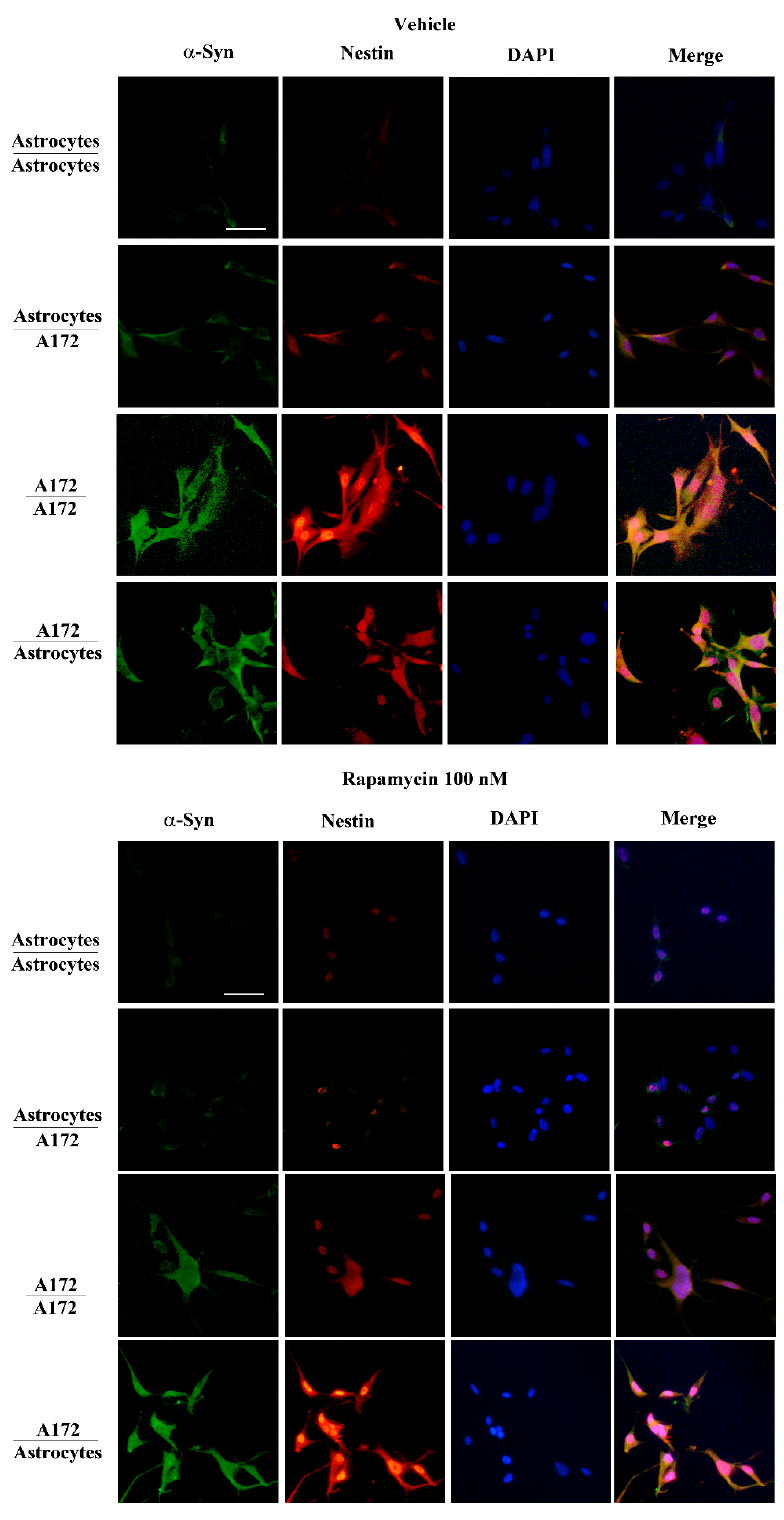
Figure 10. α -Syn parallels nestin expression in co-cultures of astrocytes and A172 cells with or without rapamycin (100 nM). Representative pictures show immuno-fluorescence for α -syn (green), nestin (red) and nucleus DAPI fluorescence (blue) and their merge, within co-cultures of astrocytes and A172 cells in baseline conditions (vehicle) and following rapamycin administration (Rapamycin 100 nM). Scale bar = 30 µ